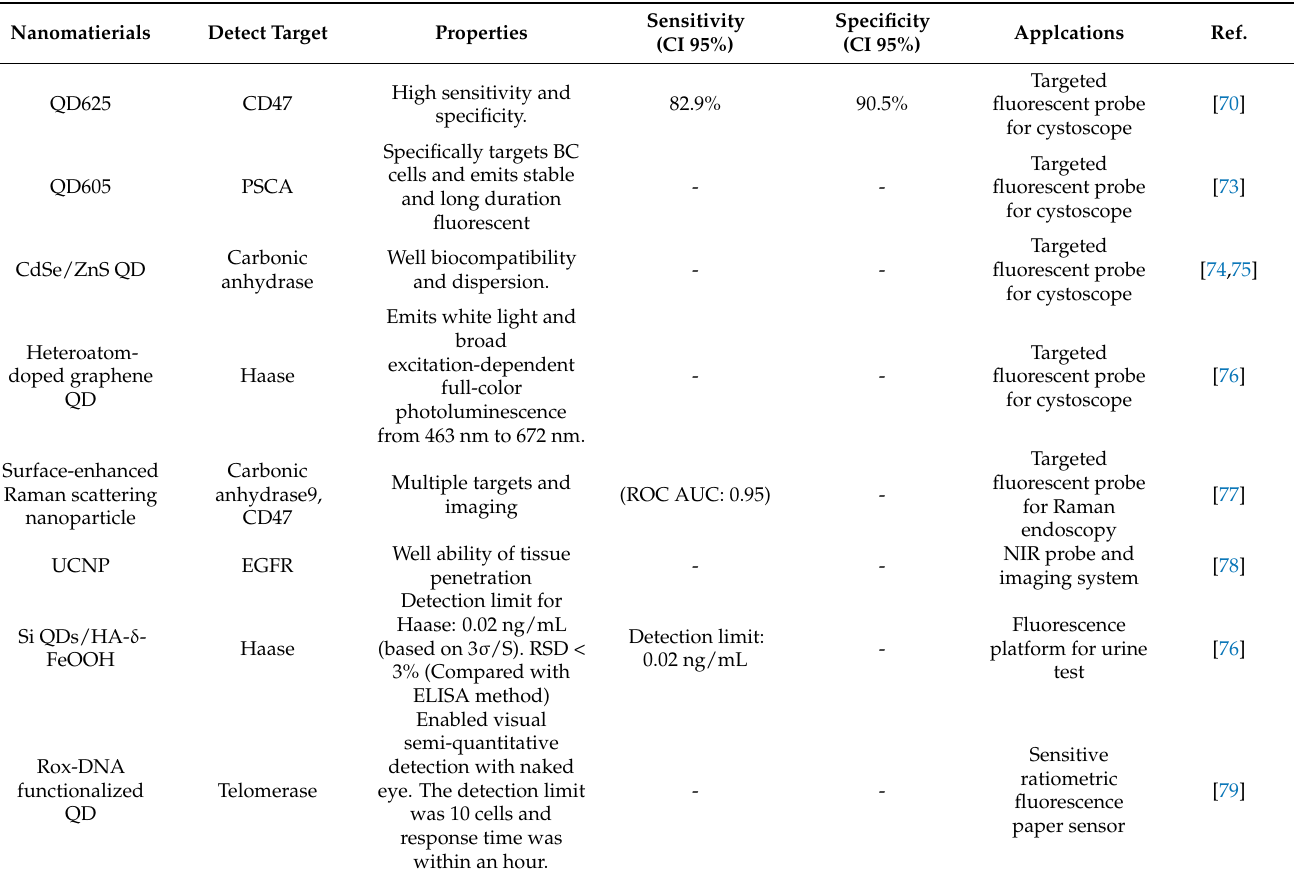
Table 2. Nano-prognostic methods for bladder